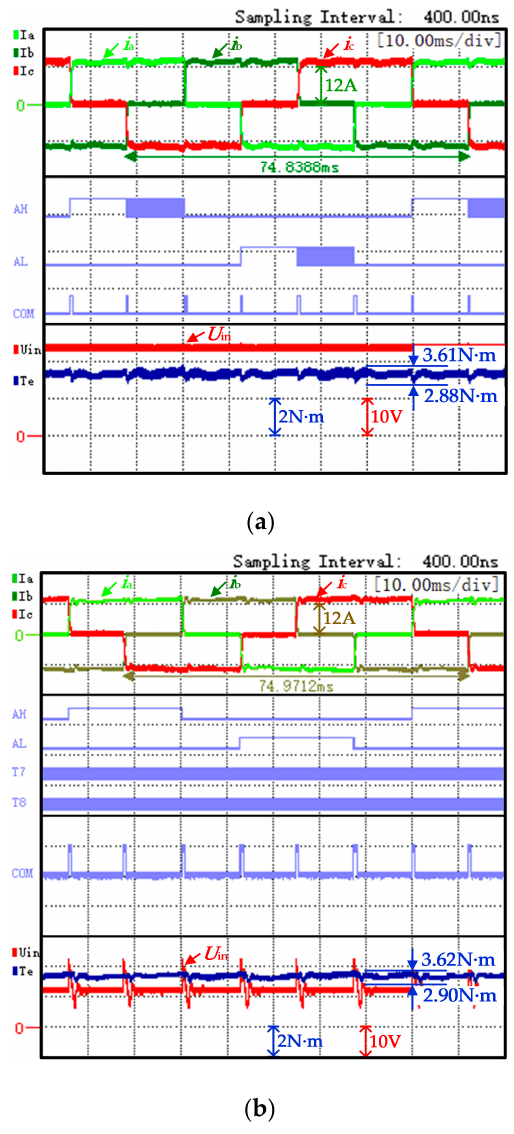
Figure 13. The experimental results with low speed condition: ( a ) traditional strategy; and ( b ) proposed strategy. Table 2. Torque ripple rate K rT under different operating conditions.